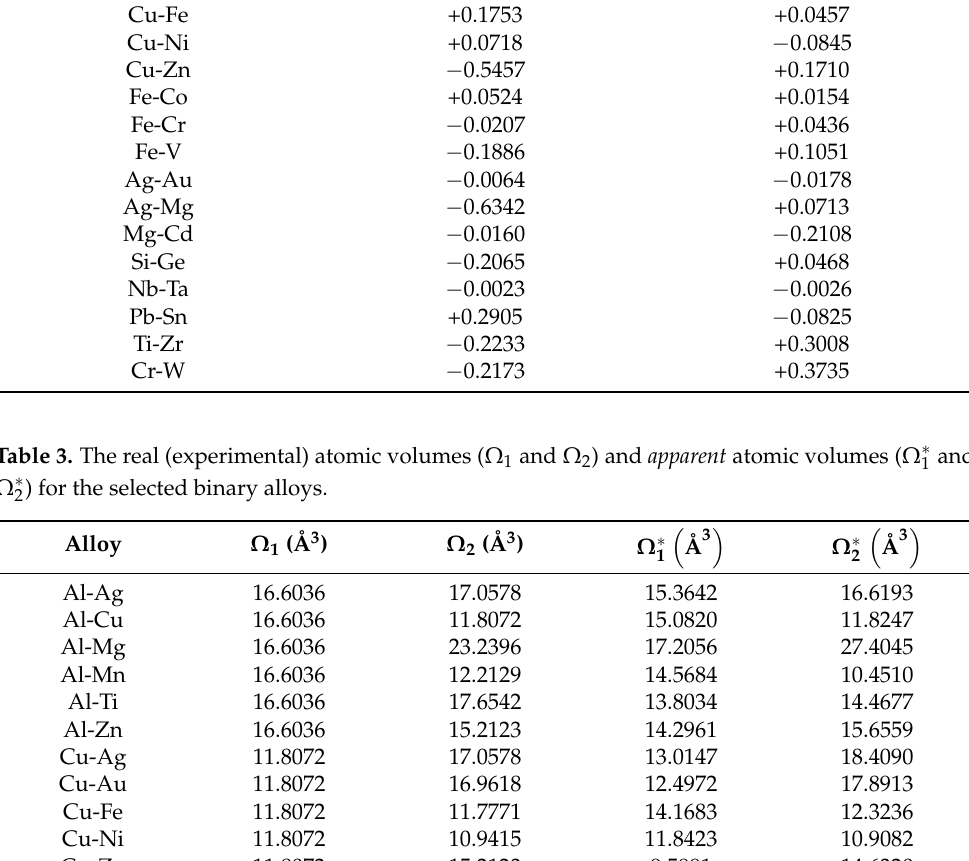
Table 2. The volume size factor data: ω 1 is the volume size factor when the first element of the alloy system is the solute, and ω 2 when the second element is the solute [11].